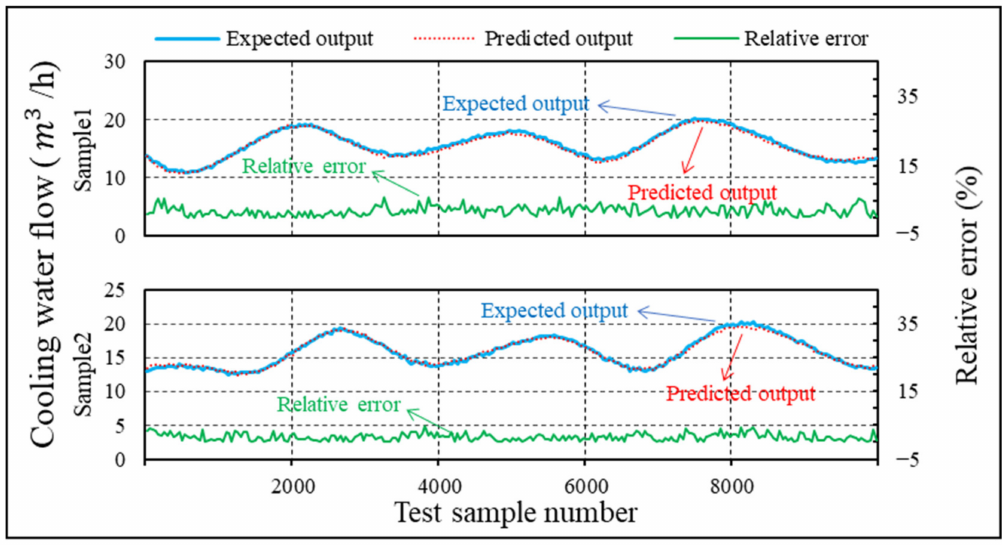
Figure 9. Predicted cooling water flow by